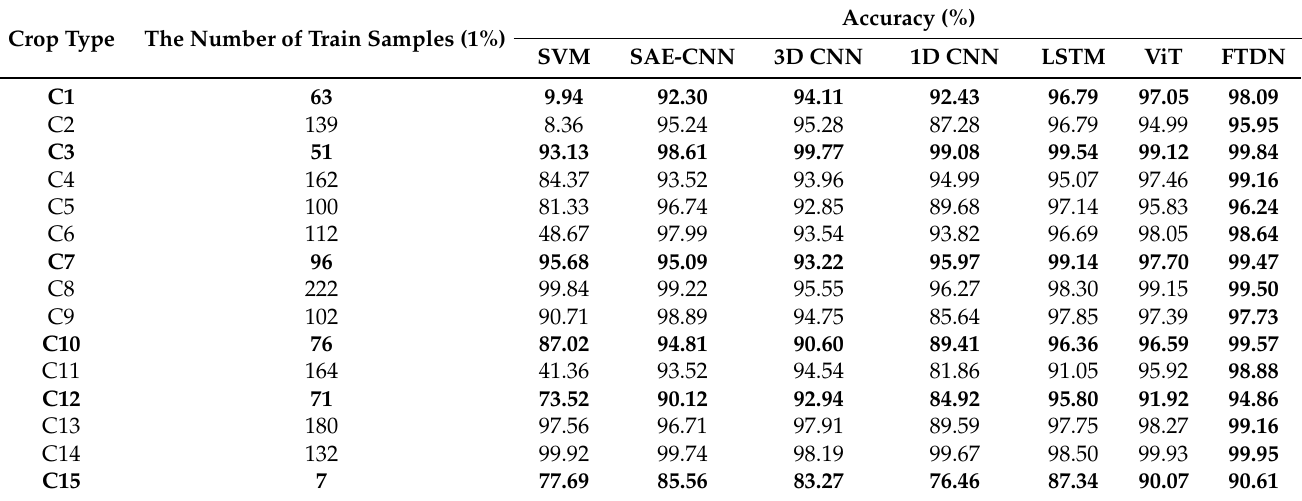
Table 5. The recall rates of different classifiers for each crop.